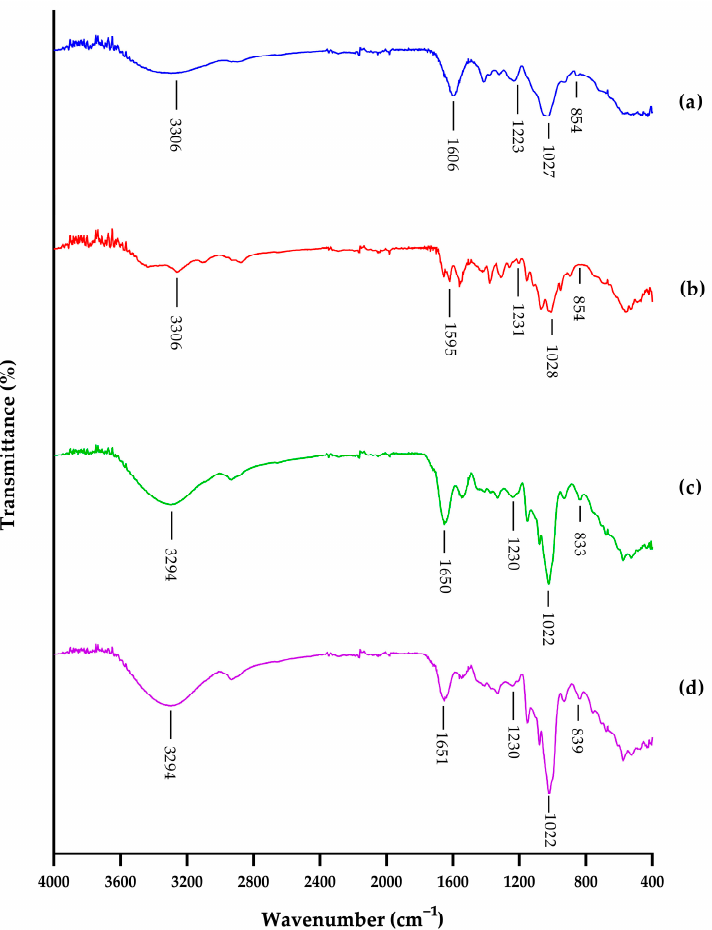
Figure 3. FTIR spectra of ( a ) chondroitin-4-sulfate; ( b ) chondroitin-6-sulfate; ( c ) chondroitin sulfate from head cartilage of skipjack tuna ( Katsuwonus pelamis ); ( d ) chondroitin sulfate from head cartilage of yellowfin tuna ( Thunnus albacares ).